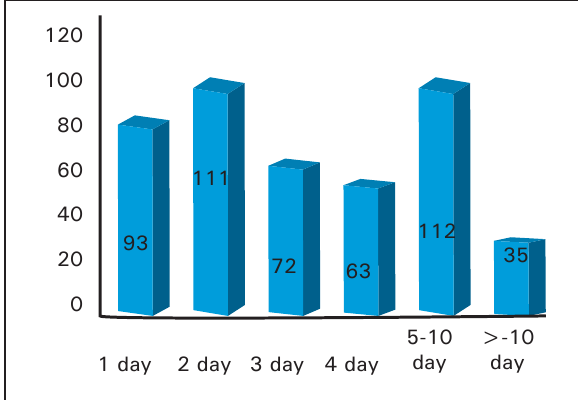
Figure 3. Average Length of Stay on Mechanical Ventilation (LOS